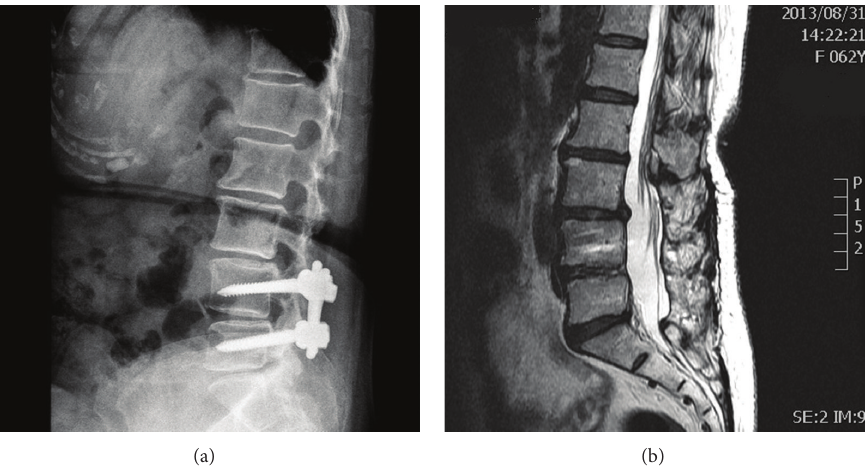
Figure 1: An illustrative patient who received open lumbar surgery at L4-5 level with adjacent segment degeneration at L3-4 level. (a) A lateral plain radiograph taken preoperatively showing previous internal fixation at L4-5 level. (b) Preoperative sagittal T2-weighted magnetic resonance imaging scan showing adjacent segment degeneration at L3-4